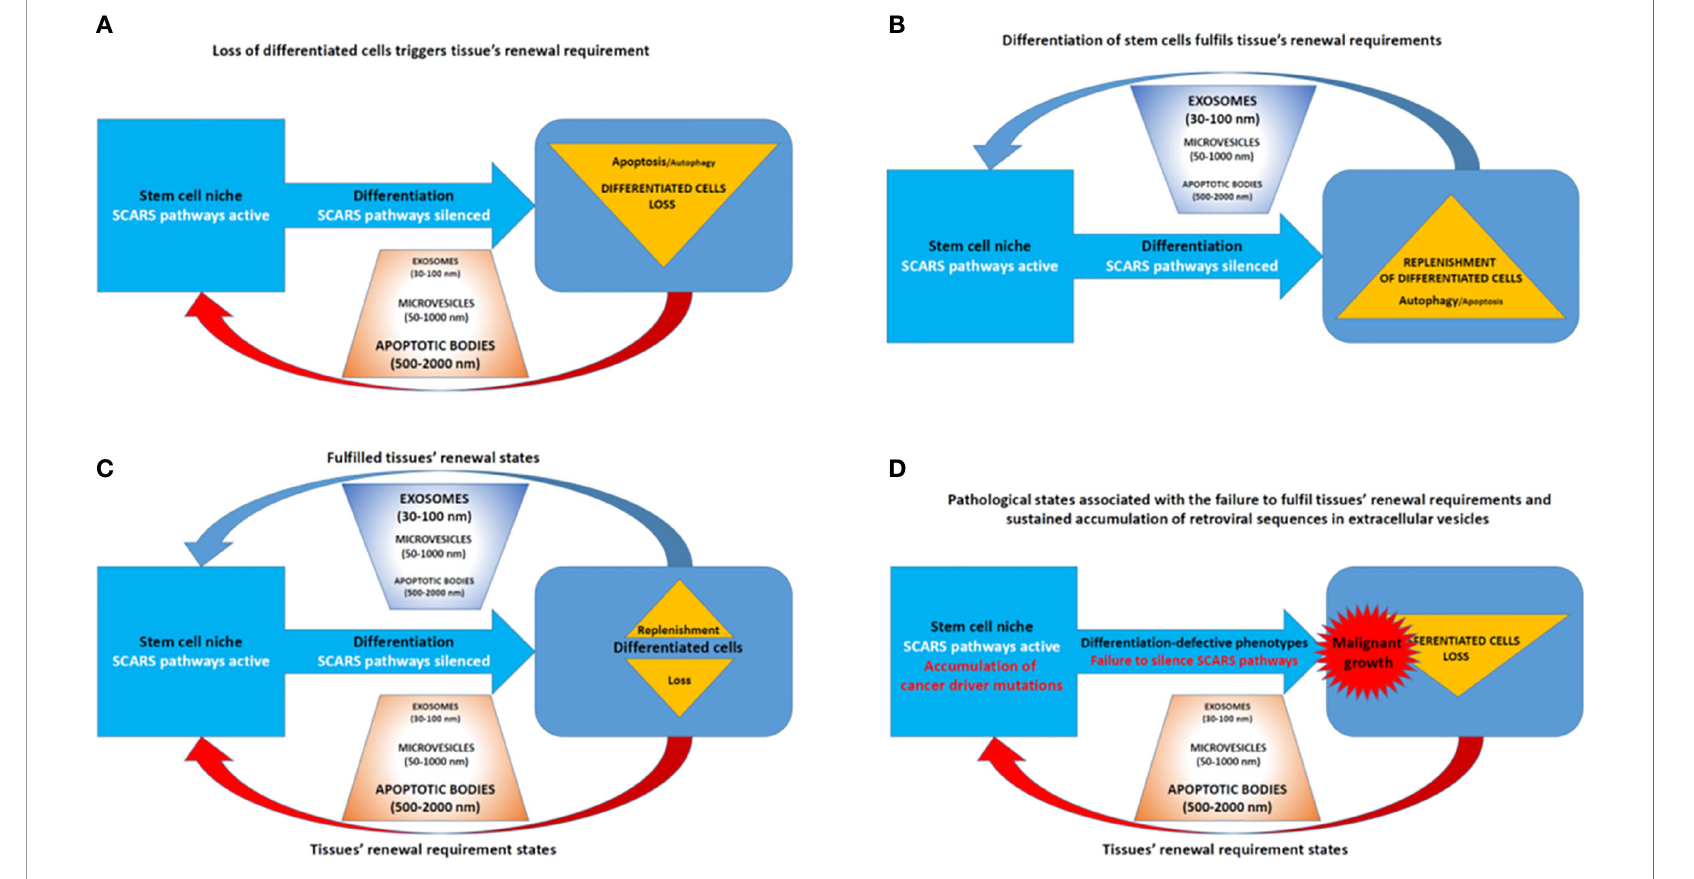
FIGURE 8 | Extracellular vesicles (EVs) — Guided regulation of tissue homeostasis cycles of the loss and replenishment of differentiated cells. (A) A model of tissue homeostasis at the loss of differentiated cells stage. (B) A model of tissue homeostasis at the stage of completed replenishment of the loss of differentiated cells. (C) Continuing maintenance of tissue homeostasis cycles is associated with fl uctuations of distinct types of EVs. (D) A model of pathological states associated with altered tissue homeostasis due to the failure of differentiated cells